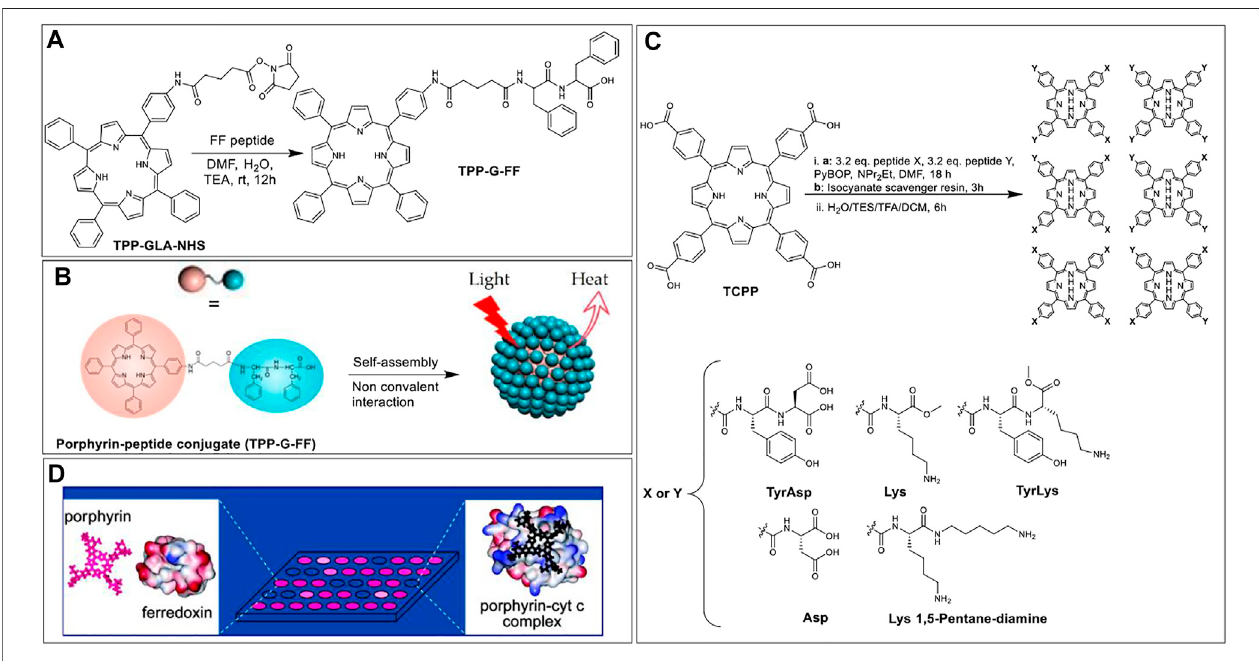
FIGURE 12 | (A) Porphyrin NHS ester coupled with FF peptide to afford conjugate TPP-G-FF. (B) Schematic illustrating the self-assembly of TPP-G-FF into nanodots. Reprinted by permission from (Zou et al., 2017). (C) Scheme of mixed condensation synthesis toform porphyrin based protein-surface binders (Baldini et al., 2004). (D) Illustrationofasensing platform wherelowbindingaf fi nityofaporphyrin receptor withferrodoxinresultsinnegligible fl uorescenceintensitychange(left); while the high binding af fi nity of the receptor to cyt c results in quenched fl uorescence (right). Reprinted by permission from (Baldini et al., 2004).